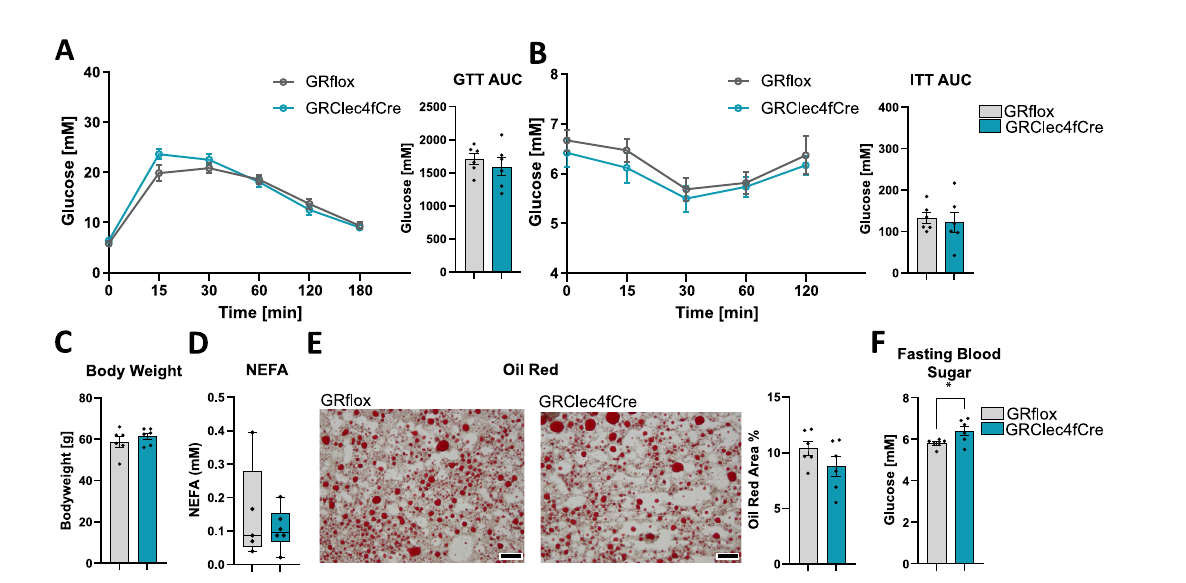
Fig. 4 | Selective elimination of GR in Kupffer cells does not increase IR, lipo- lysis, and steatosis after HFD. A Overnight fasted obese, 29 weeks ofHFD, GR fl ox , and GR Clec4fCre mice were given 2mg/g glucose i.p., and blood glucose levels were traced for 180min. The area under the curve, right ( n =6). B Obese GR fl ox and GR Clec4fCre mice were fasted for 4h, and given 0.5 µ i.U./g insulin i.p., and blood glucose levels were traced for 120min. The area above the curve, right ( n =6). C BodyweightatthetimeofdissectionfromobeseGR fl ox andGR Clec4fCre mice( n =6).